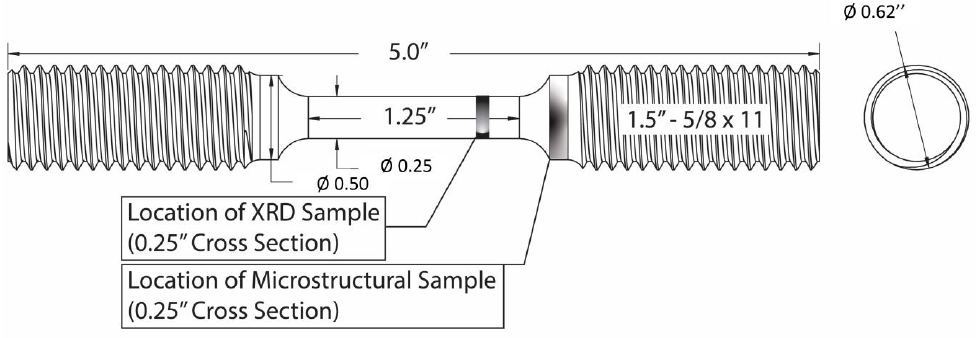
Figure 1. Drawing of the standard ASTM E8 tensile test specimen [18]. Highlighted areas show location of XRD and microstructural samples.